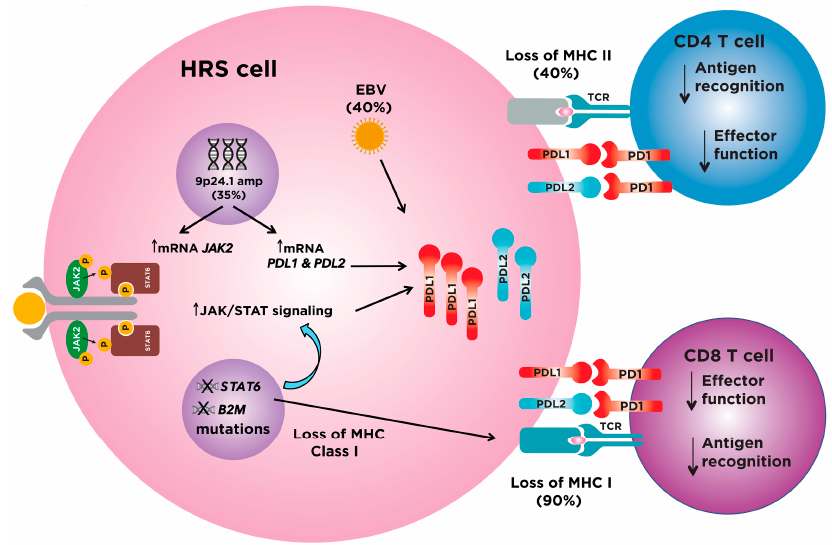
Figure 1. Hodgkin Reed-Sternberg (HRS) cells escape immune detection by over-expressing program death ligands PDL1/PDL2 and silencing Major Histocompatibility Complex (MHC) expression. HRS cells over-express PDL1 and PDL2, both ligands for PD1 on T cells, which once engaged, suppresses T cell effector function. The main mechanisms of over-expression are amplification of 9p24.1, the location of PDL1, PDL2 and Janus kinase 2 (JAK2). Over 90% of classical Hodgkin Lymphomas (cHLs) harbor genetic alterations that may activate JAK/STAT signaling, the most common being JAK2 and STAT6, which can ultimately increase PDL1 expression. Epstein–Bar Virus (EBV) can further increase the expression of PDL1 and PDL2. HRS cells can also promote immune tolerance by silencing the expression of MHC class I and II molecules, which are key to present tumor antigens and activate CD8 and CD4 T cells, respectively. Abbreviations: HRS, Hodgkin Reed–Sternberg; PDL1, program